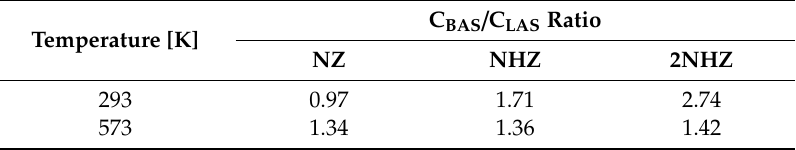
Table 3. Acid sites ratio of natural and modified zeolite samples.